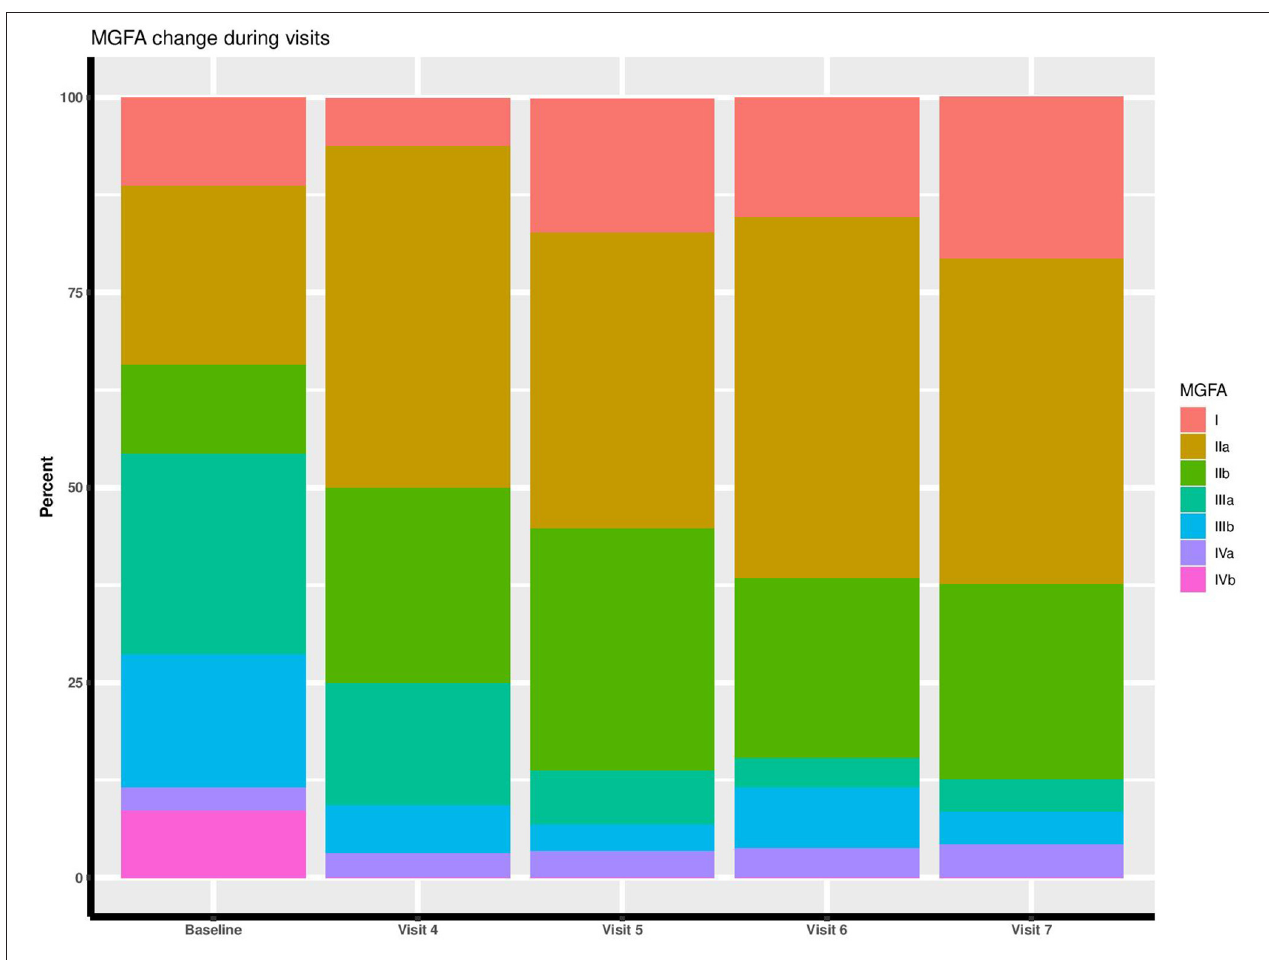
FIGURE 3 | Myasthenia Gravis Foundation of America (MGFA) clinical classification of participants across